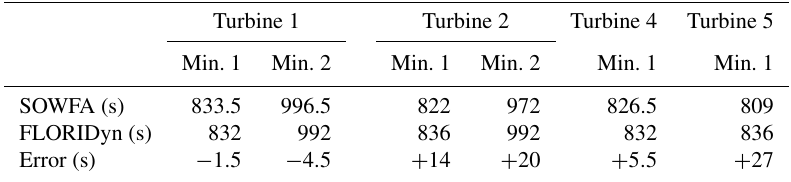
Figure 11. Power generated in the nine-turbine case. The grey area marks the time window in which the wind direction linearly changes by 60 ◦ . The plots are arranged to fit the layout of the wind farm in Fig. 9. The data show the zero-phase-filtered (zp. f.) and the unfiltered (unf.) SOWFA data, as well as the filtered (f.) and unfiltered FLORIDyn data. Table 2. Points in time at which the power generated in the nine-turbine case is minimal due to wake